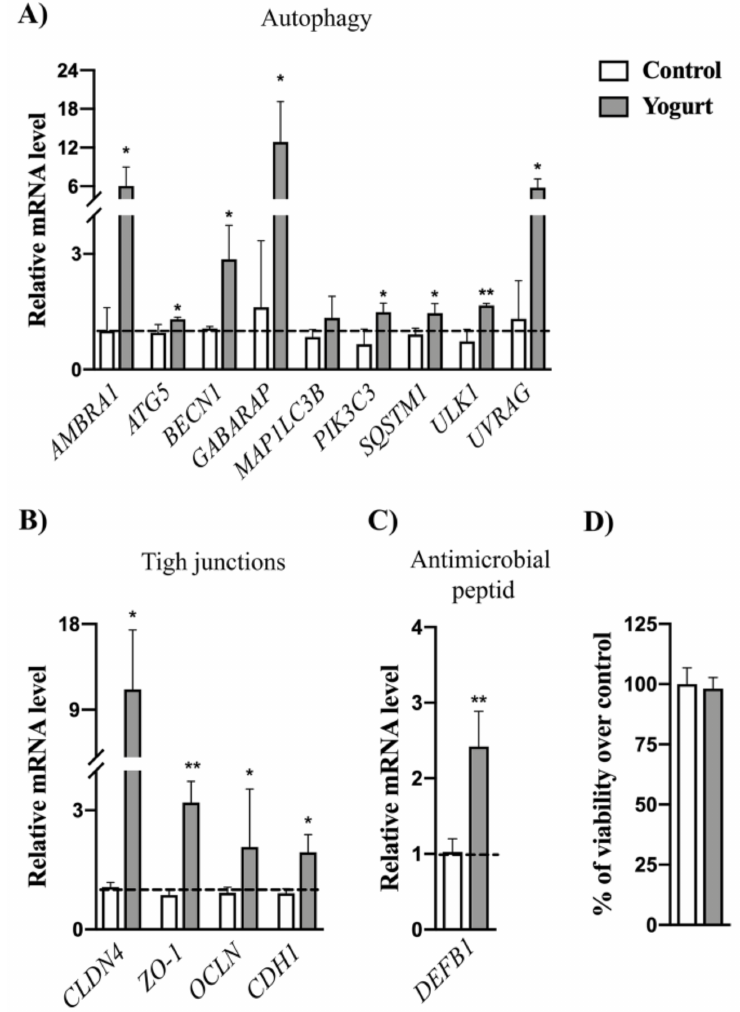
Figure 3. Yogurt application strengthens gut epithelial barrier. Expression of autophagy-related genes ( A ), tight-junction proteins genes ( B ), and human β defensin ( C ) in Caco-2 cells treated with yogurt. E ff ect of yogurt on Caco-2 cells viability measured by lactate dehydrogenase (LDH) assay ( D ). Student’s t-test was used to compare di ff erences between groups (* p < 0.05, ** p < 0.01). Caco-2 cells treated with phosphate-bu ff ered saline (PBS) were used as negative